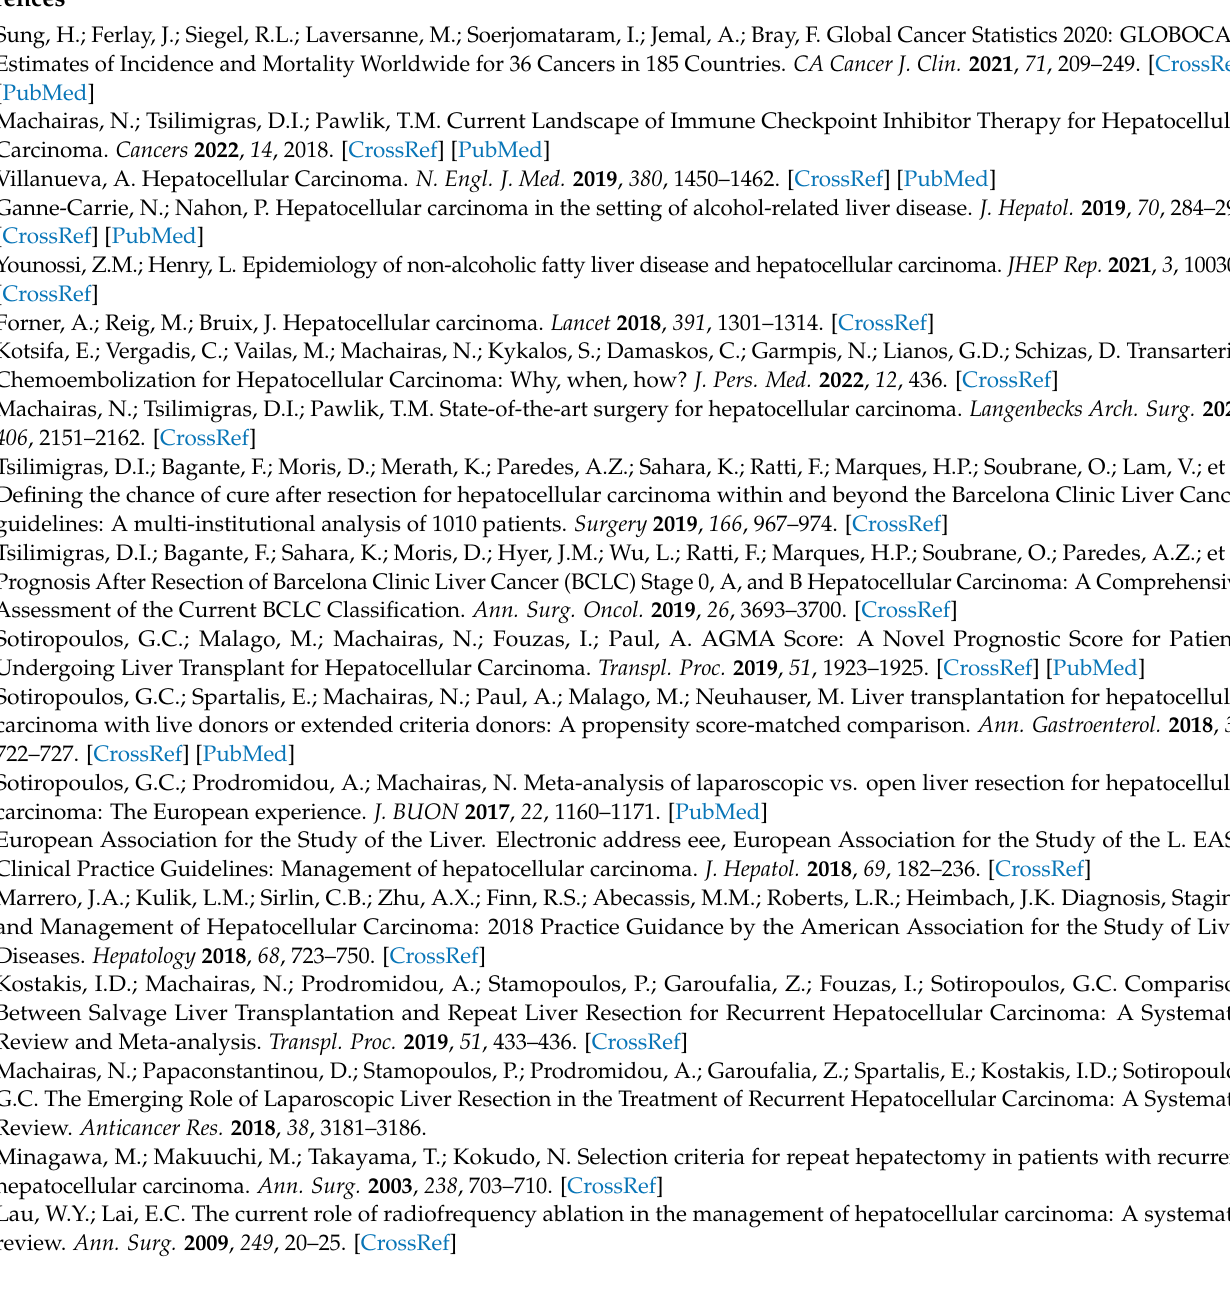
survival analysis, Figure S12: Funnel plot of studies included in the disease-free survival analysis, Figure S13: Funnel plot of studies included in the second recurrence analysis, Figure S14: Funnel plot of studies included in the morbidity analysis, Figure S15: Funnel plot of studies included in the ≥ CDIII morbidity analysis, Figure S16: Funnel plot of studies included in the mortality analysis, Table S1: Risk of bias summary for non-randomized studies using the ROBINS-I tool, Table S2. Risk of bias summary for randomized controlled trials using the RoB 2